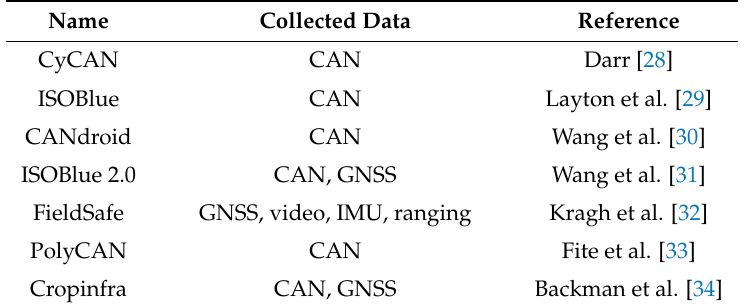
Table 1. A list of selected custom hardware platforms for agricultural machinery data collection.